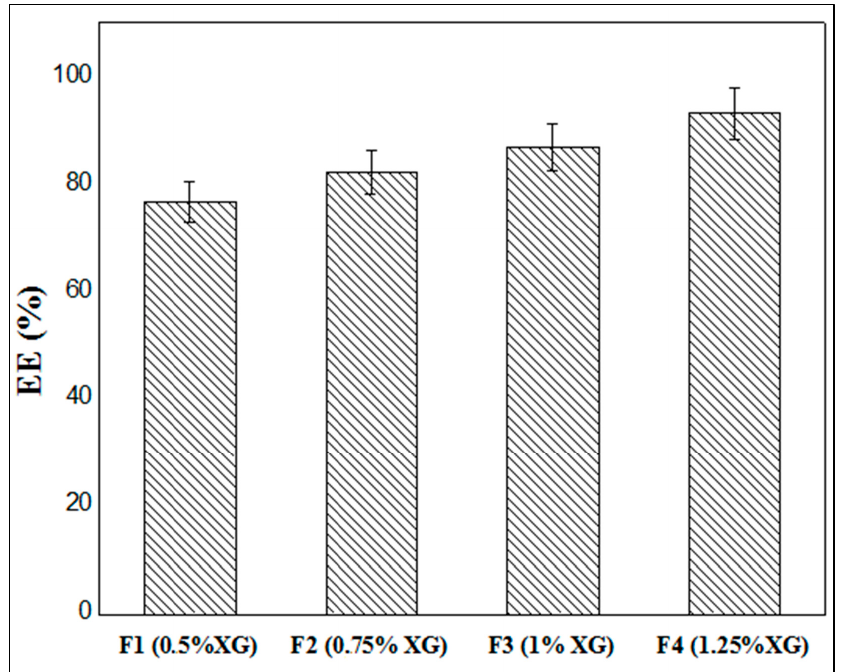
Figure 7. Entrappement efficiency of MTH